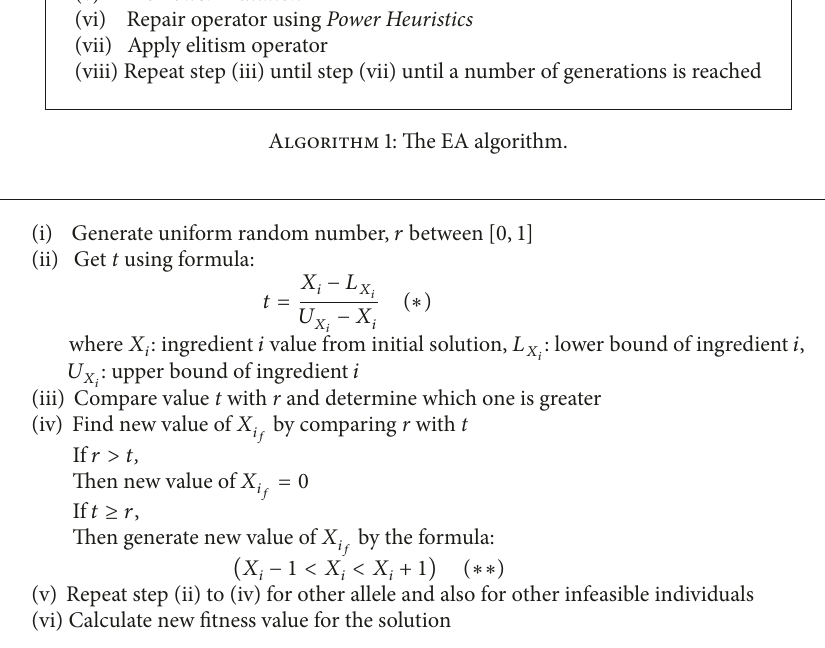
Algorithm 2: Power Heuristics algorithm.